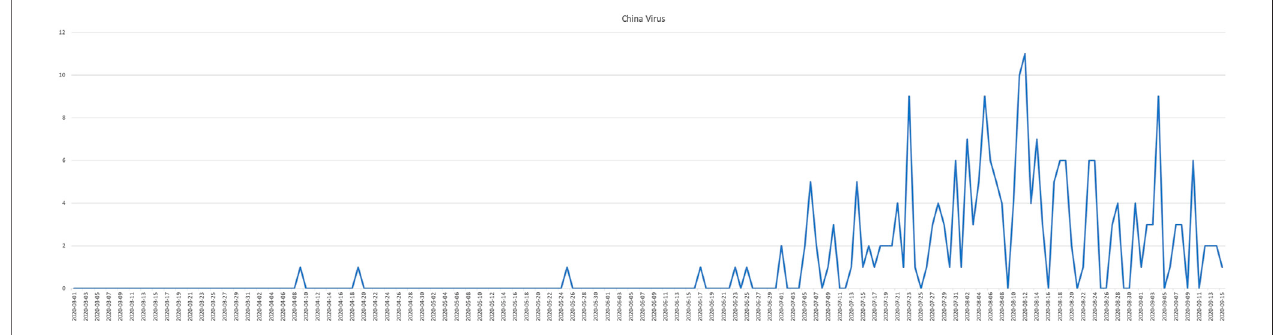
FIGURE 2 | China Virus.